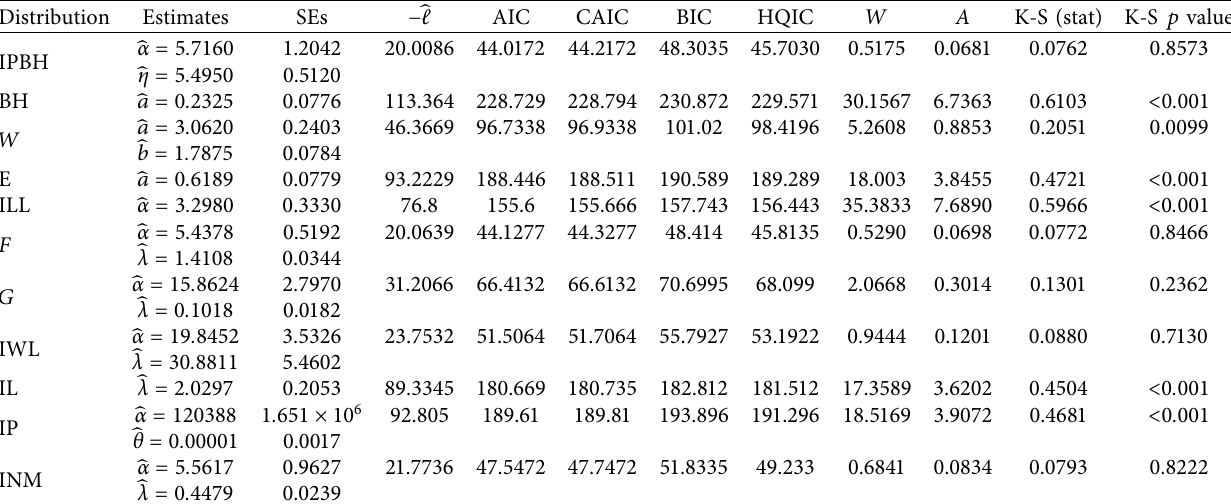
Table 6: The estimates of the parameters of the IPBH distribution and other competing models with several discrimination statistics for dataset